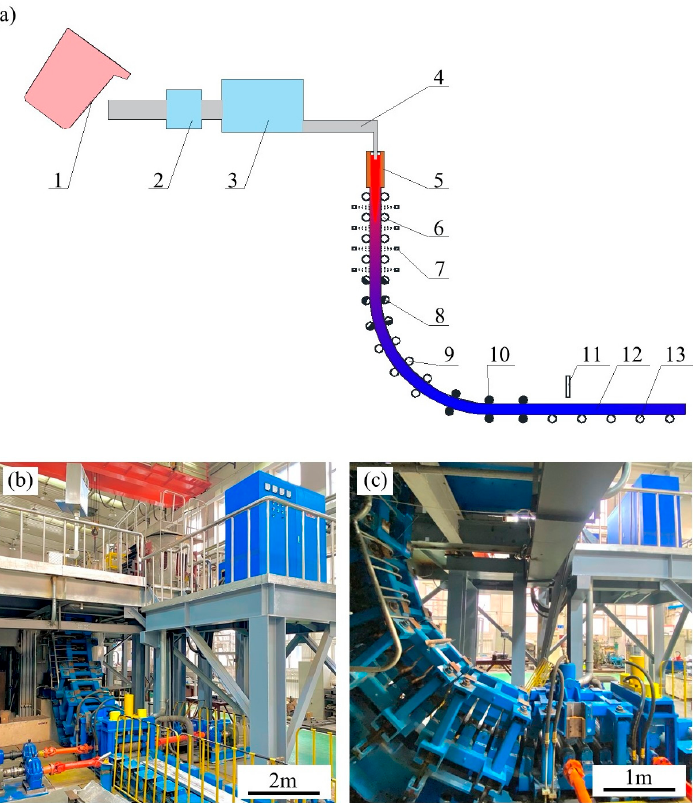
Figure 1. Schematic diagram of principle of the VC process ( a ) and photos of the pilot-scale line ( b ) and ( c ). 1—Melting furnace, 2—Degassing and purification device, 3—Holding furnace, 4—Launder and pouring system, 5—Water cooled mold and oscillating device, 6—Vertical segment rollers, 7—Spray cooling device, 8—Bending segment rollers, 9—Arc segment rollers, 10—Straightening machine, 11—Cutter, 12—Slab, 13—Horizontal roller